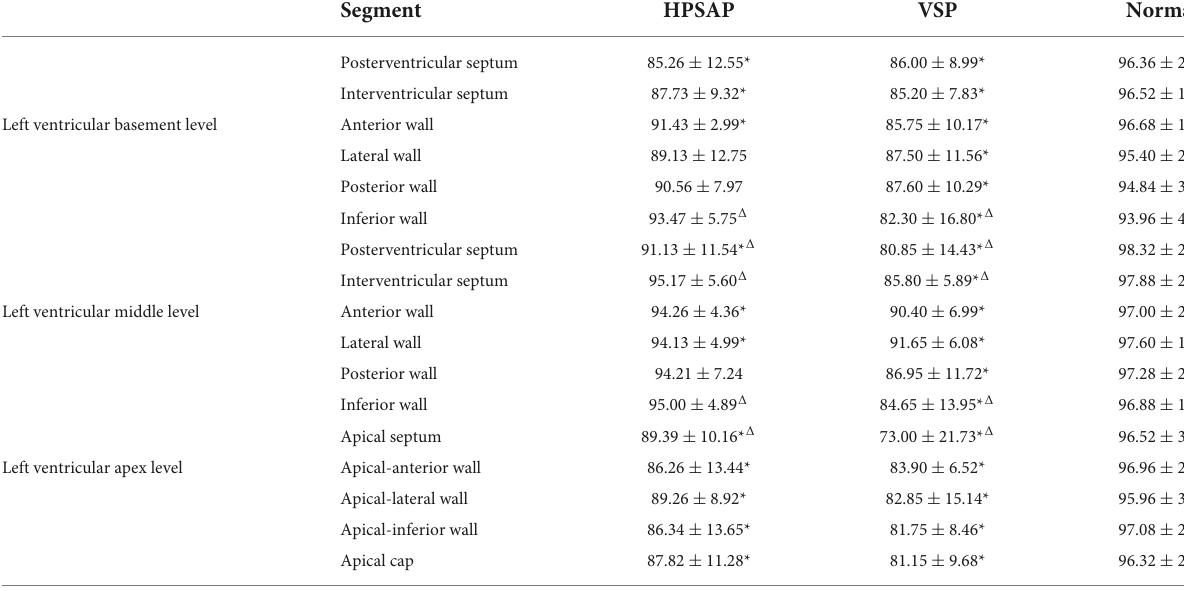
TABLE 3 Comparison of myocardial constructive work among the three groups at 17 segments of the left ventricle ( x ± s , %).